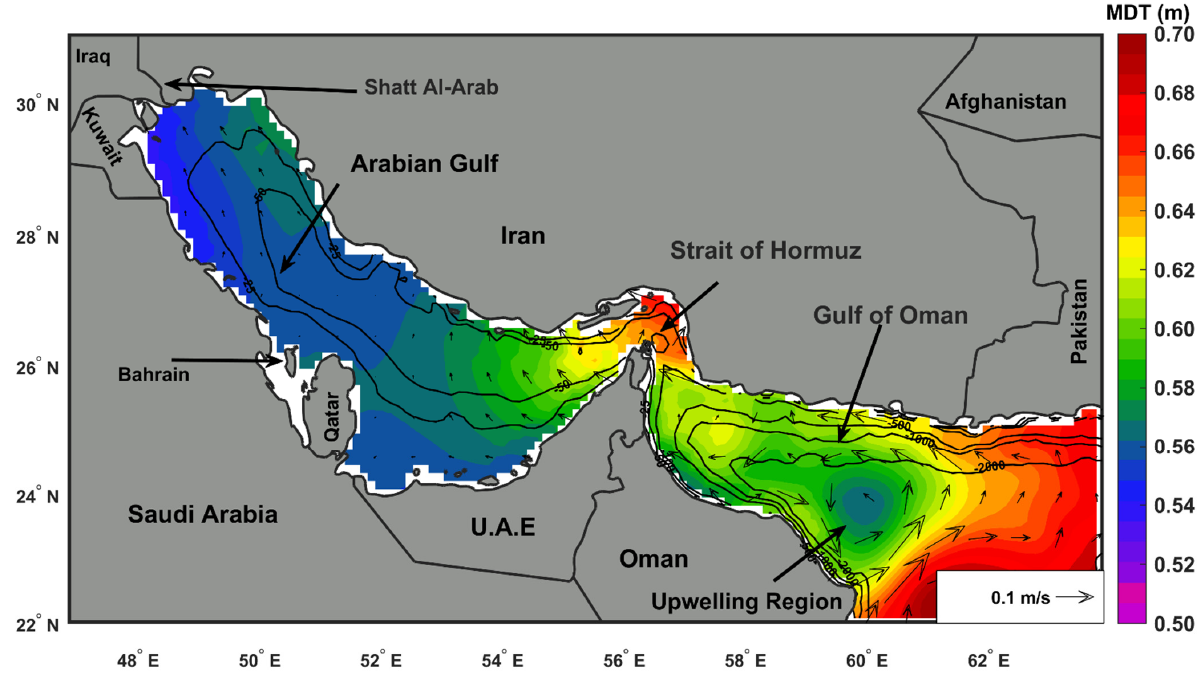
Figure 1. The mean dynamic topography (MDT) from 1993–2012 (shading, in meters) and general geostrophic circulation (black arrows, in m/sec) of the Arabian and Oman Gulfs were obtained from (MDT Global CNES-CLS18: Aviso+ (altimetry.fr); accessed on 30 April 2022), with the main geographic features (e.g., countries and rivers). Isobaths of 25, 50, 500, 1000, and 2000 m are shown as white contours obtained from the General Bathymetric Chart of the Oceans (GEBCO) (www.gebco.net; accessed on 15 April 2022).